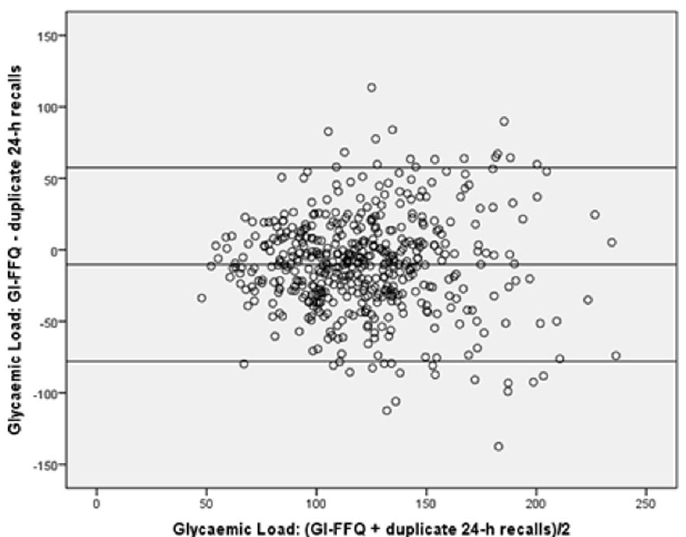
Figure 4. Bland-Altman plot for glycaemic load showing the relative validity of the GI-FFQ versus the duplicate 24 h-recall. Middle line indicates the mean; upper and lower lines indicate borders based on mean ± SD × 1.96 (i.e., − 10.2+/ −